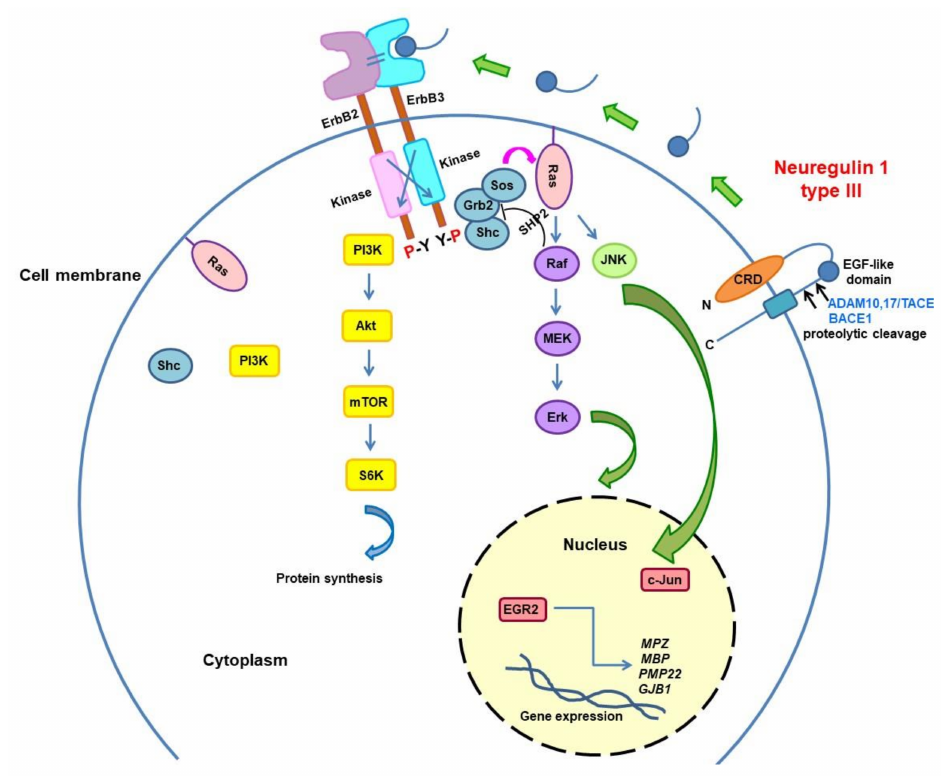
Figure 2. Neuregulin1/ErbB signalling determines myelin sheath thickness. Neuregulin1 type III (Nrg1-III) has an epidermal growth factor-like (EGF-like) domain and contains a cysteine-rich domain (CRD) embedded in the lipid bilayer, which leaves the N-terminal side tethered to the membrane. Nrg1-III, produced by axons, is proteolytically cleaved by proteases of the ADAM family and BACE1. The BACE1 and TACE (also known as ADAM17) secretases are Nrg1-III regulators with opposite actions, the first by enhancing its activity and thus increasing myelin thickness, whereas the latter has an inhibitory effect. Nrg1-III provides the ligand for ErbB3 receptor leading to its heterodimerisation with ErbB2, activation of the tyrosine kinase domain, and phosphorylation of the cytoplasmic region of the ErbB partner. This event causes various adaptors/effectors’ (e.g., Ras-Shc, PI3K) recruitment and activation of multiple intracellular signalling pathways such as the PI3K–Akt and MAPK/Erk pathways in the Schwann